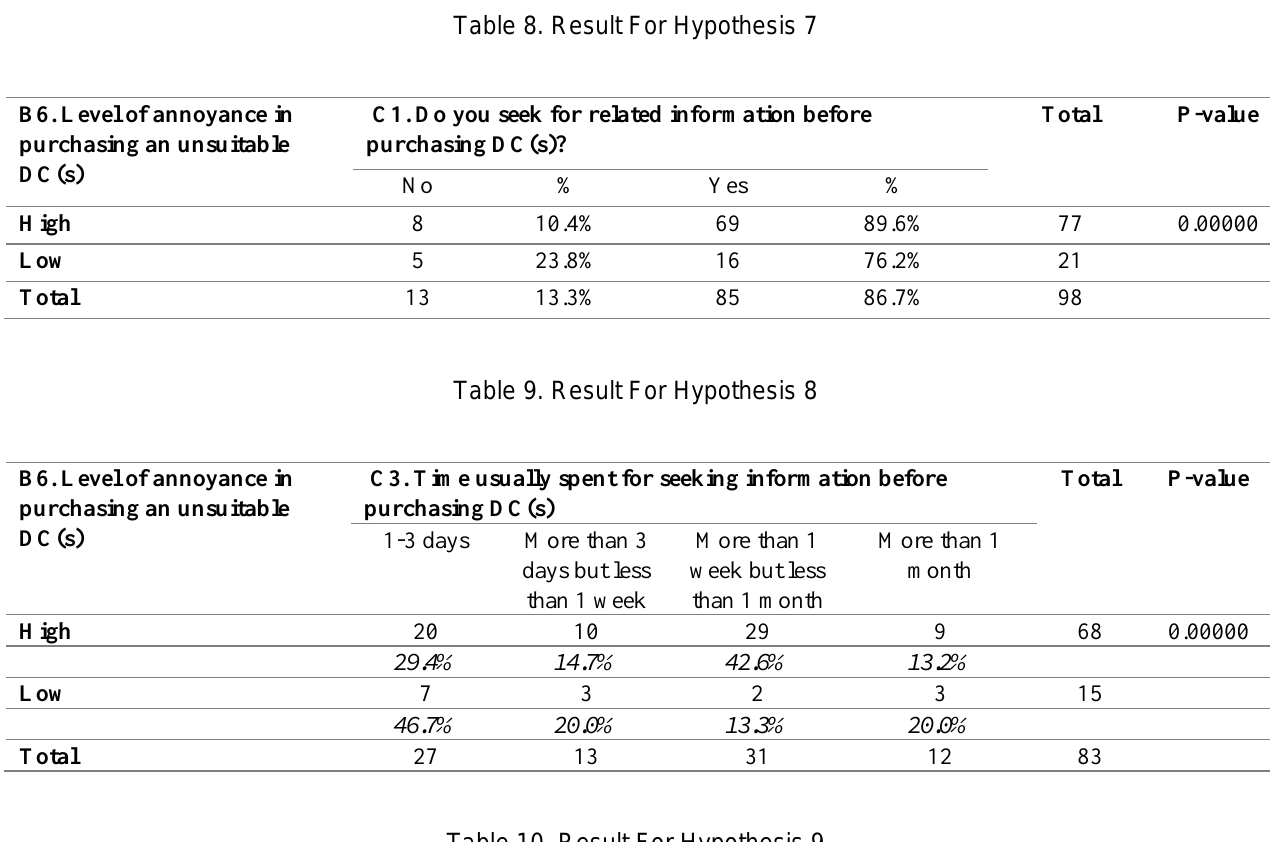
Table 7. Result For Hypothesis 6